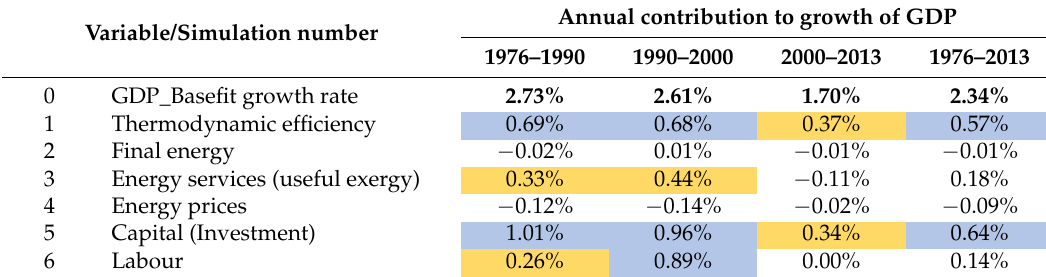
Table 1. Simulations—contributions to GDP growth